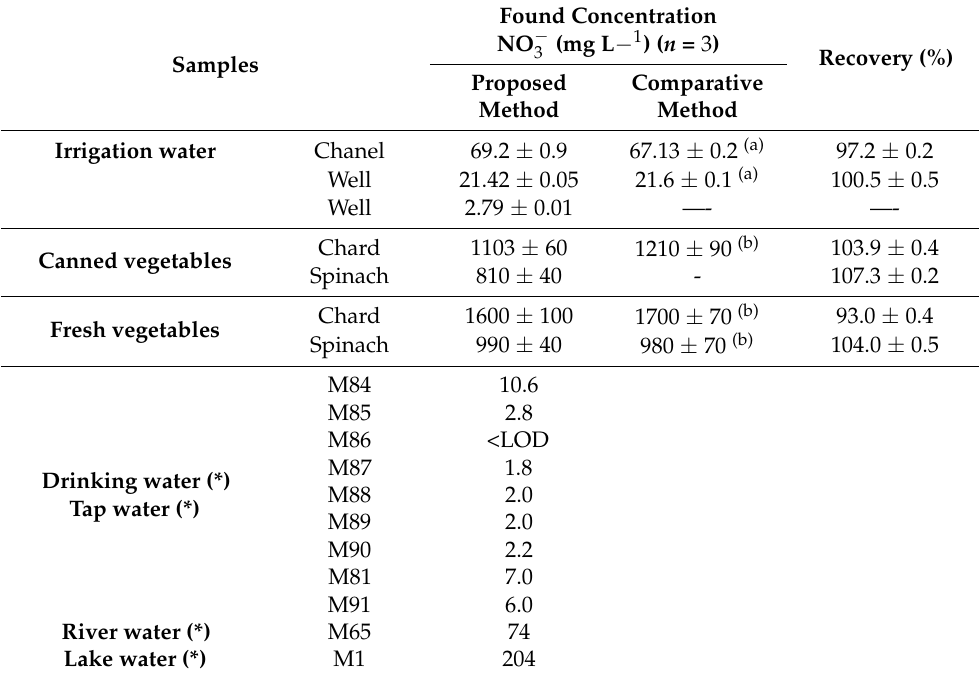
Table 3. Found concentrations of NO − in different real samples (irrigation water samples, water from 3 canned and boiled fresh green vegetables, river, drinking and tap water). Recoveries